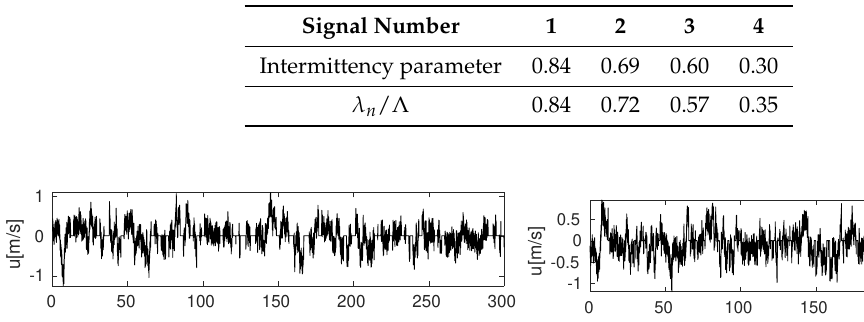
Table 1. Intermittency parameter vs. Taylor-to-Liepmann scale ratio.